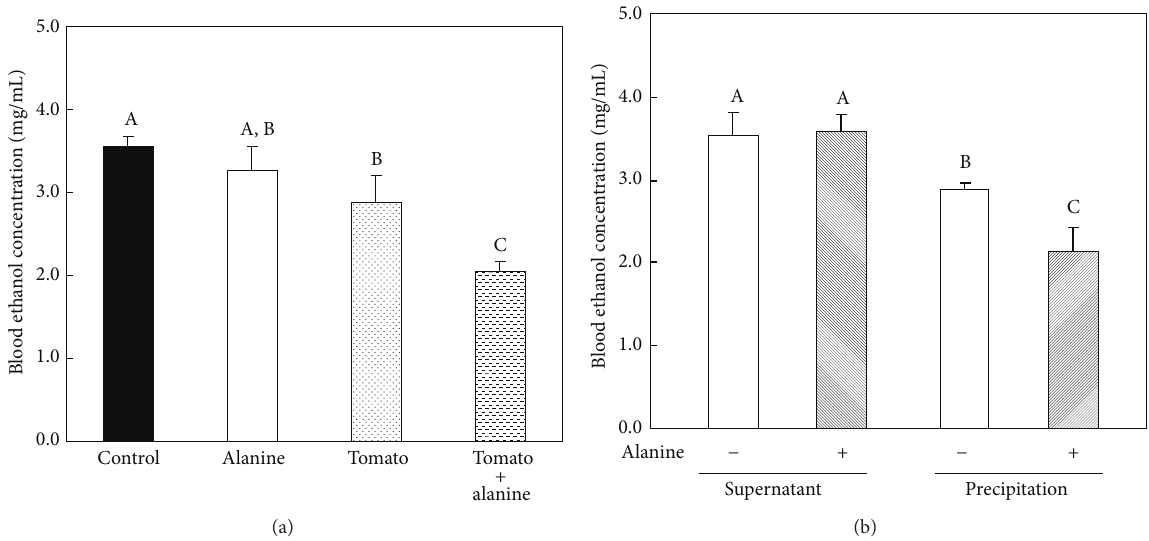
Figure 3: Blood ethanol concentrations 4h following ingestion of 4.0g/kg of ethanol after the administration of each sample in Experiments 2A and 2B. The rats were orally given 20 mL/kg of tomato juice, 5.0% alanine aqueous solution, tomato juice with 5.0% alanine, or water (control) in Experiment 2A and the tomato juice supernatant with or without 5.0% alanine or the tomato juice precipitate with or without 5.0% alanine in Experiment 2B. Results are expressed as mean and standard deviation ( 𝑛 = 4 ). Mean values with different uppercase letters differ significantly (ANOVA post hoc Tukey’s HSD test, 𝑝 < 0.05 ) among four groups.